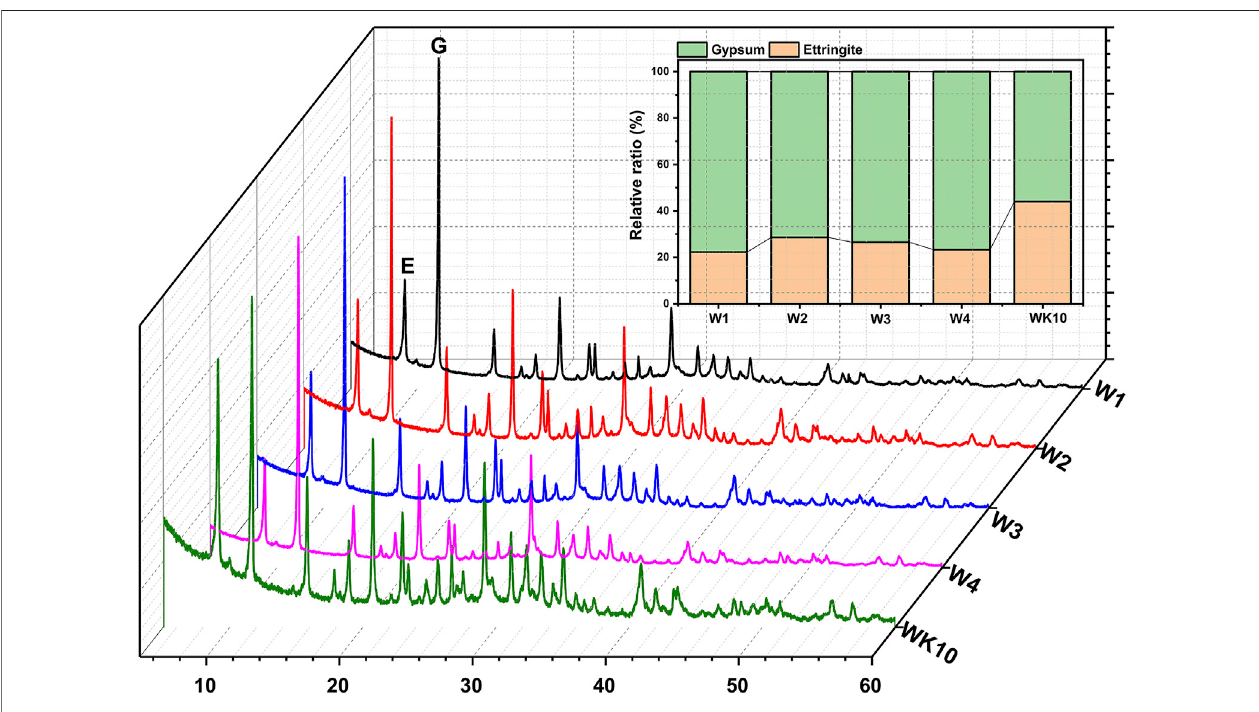
FIGURE 6 | XRD patterns of P-SSC binders at 28 days.